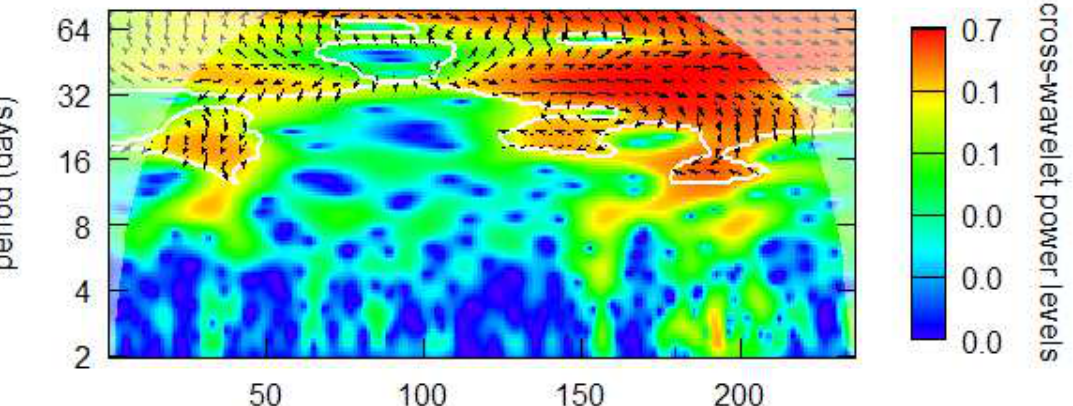
Figure 8. Shanghai Stock Exchange and London Stock Exchange